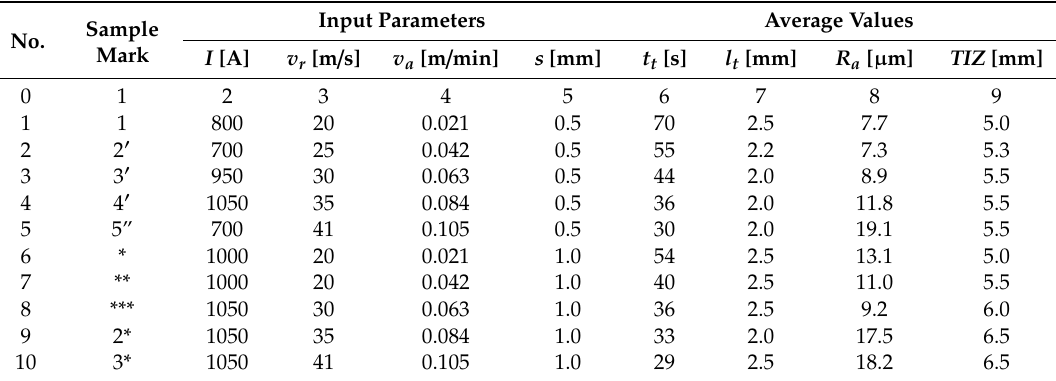
Table 1. Material 34 MoCrNi15- ϕ 40